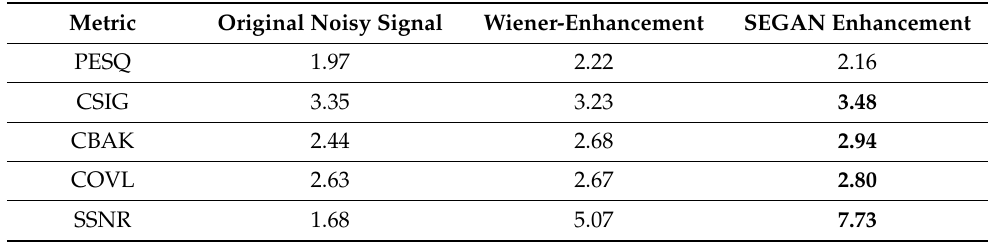
Table 12. The results of various metrics on the original data, the data generated by the benchmark model, and the data generated by SEGAN [37].